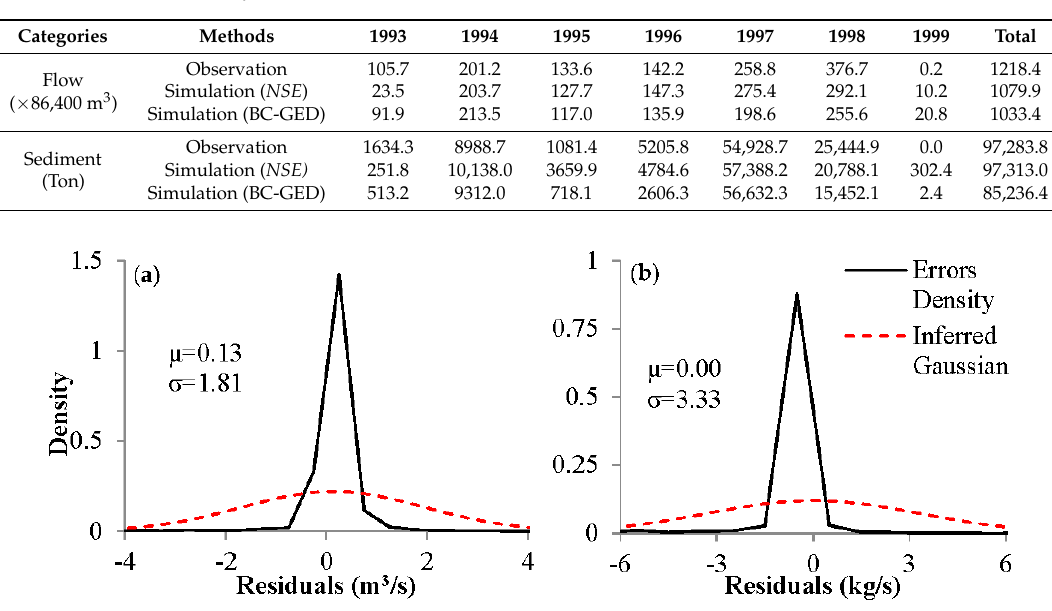
Figure 4. Empirical probability density of model residuals (black line) versus the assumed Gaussian distribution (red dash line) of the NSE approach: ( a ) flow; and ( b ) sediment.